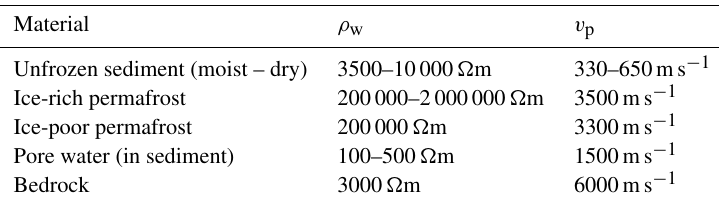
Figure 2. Overview of the work flow applied in this study. Here, ρ a denotes the apparent resistivity, ρ s the specific resistivity and v p the P-wave velocity. Table 1. Geophysical properties used in synthetic reference models. The values have been taken from literature (Barsch, 1996; Hauck and Kneisel, 2008; Hilbich et al., 2009 and references therein) and adapted to match the inverted field data in an optimal